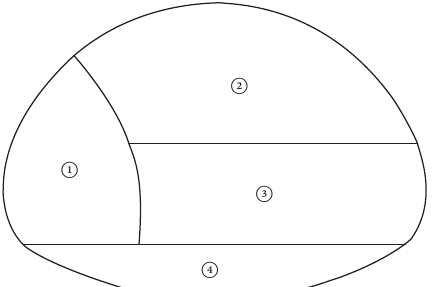
Figure 1: Construction sequence of sections of the super-large- section